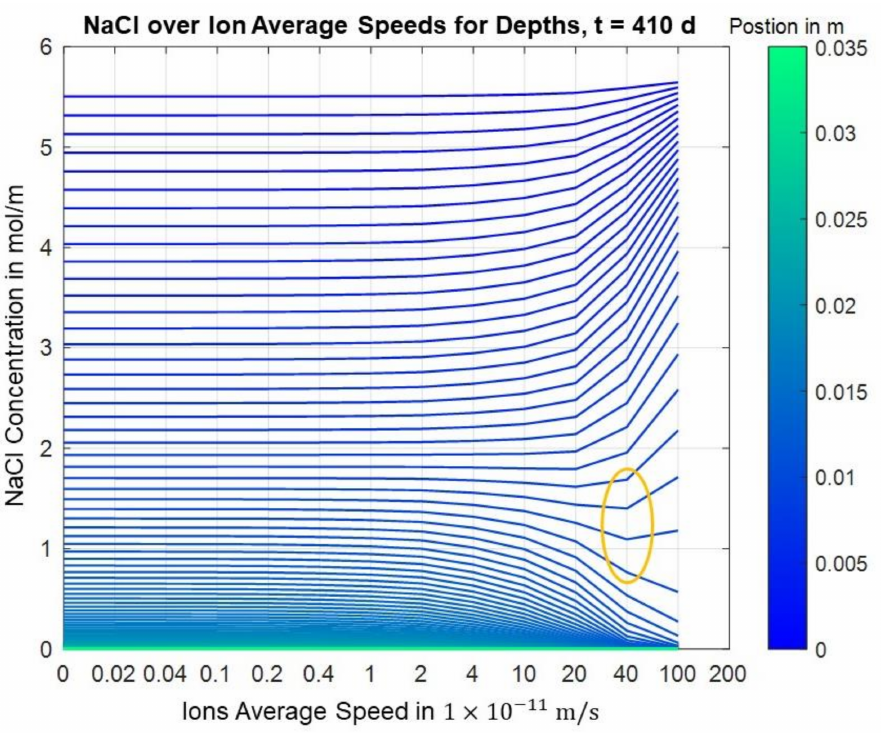
Figure 7. Finite differences solution for concentration over migration speed for different positions (t = 410 d).